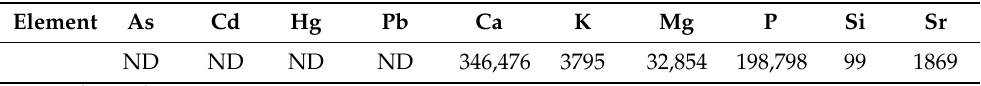
by inductively coupled plasma–optical emission spectrometry (ICP-OES) analysis (unit: